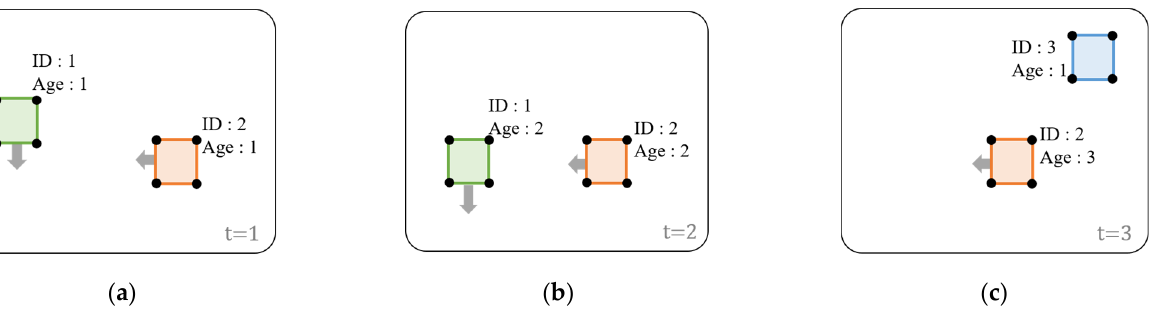
Figure 3. Object tracking. Obstacle position change with time (t) change: ( a ) examples of obstacles when t = 1; ( b ) examples of obstacles when t = 2; ( c ) examples of obstacles when t = 3.